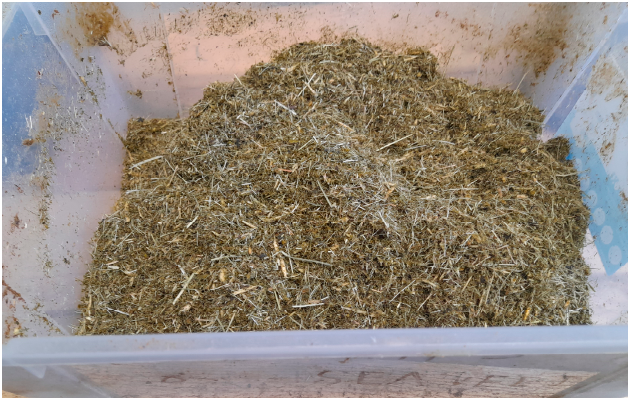
Figure A3. A mixture of seaweed, sawdust, and